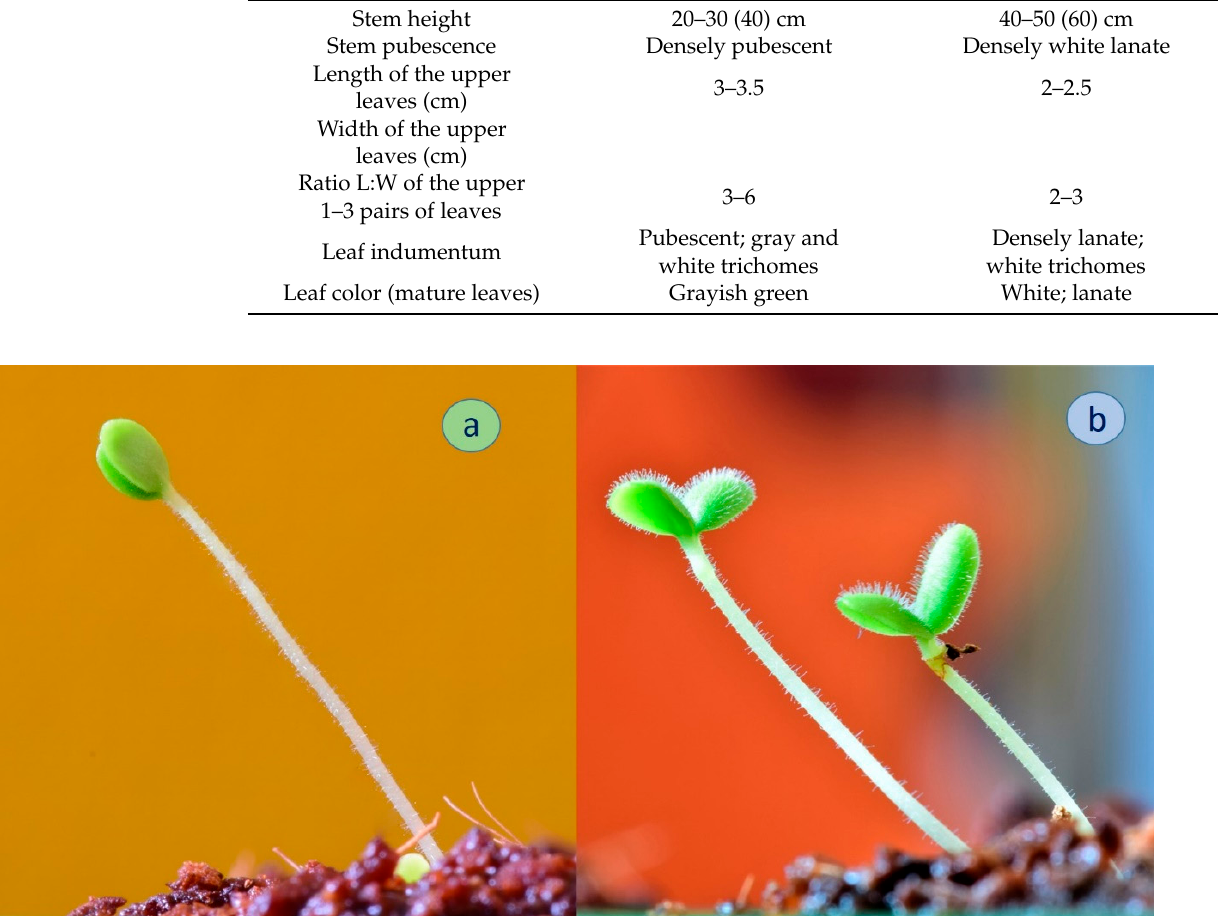
Figure 4. Juvenile plants of: ( a ) Sideritis scardica and ( b ) Sideritis elica.